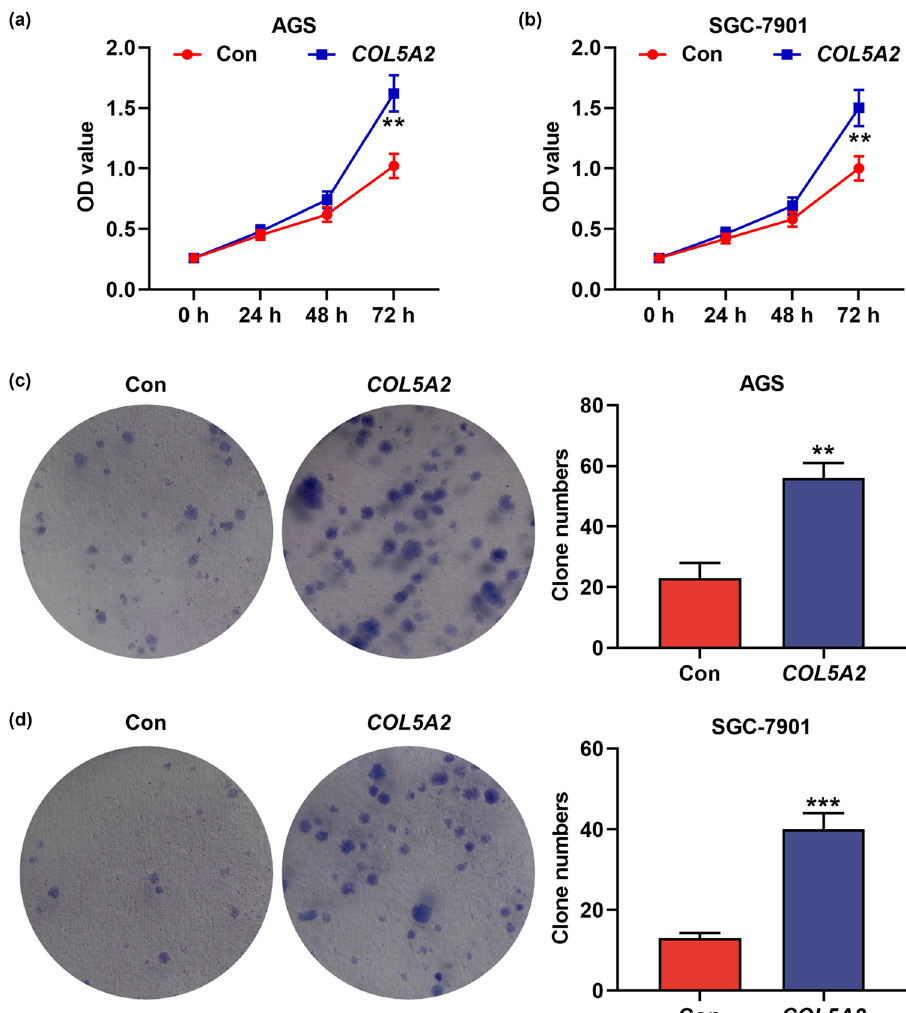
Figure 8: Overexpression of COL5A2 promoted the proliferation of GC cells. ( a and b ) After AGS and SGC - 7901 cells were transfected with COL5A2 overexpression plasmid, the viability of AGS ( a ) and SGC - 7901 cells ( b ) were analyzed by CCK - 8 assay. ( c and d ) After AGS and SGC - 7901 cells were transfected with COL5A2 overexpression plasmid, the colony number of AGS ( c ) and SGC - 7901 cells ( d ) was analyzed by colony formation assay. ** P < 0.01, *** P < 0.001 vs Con